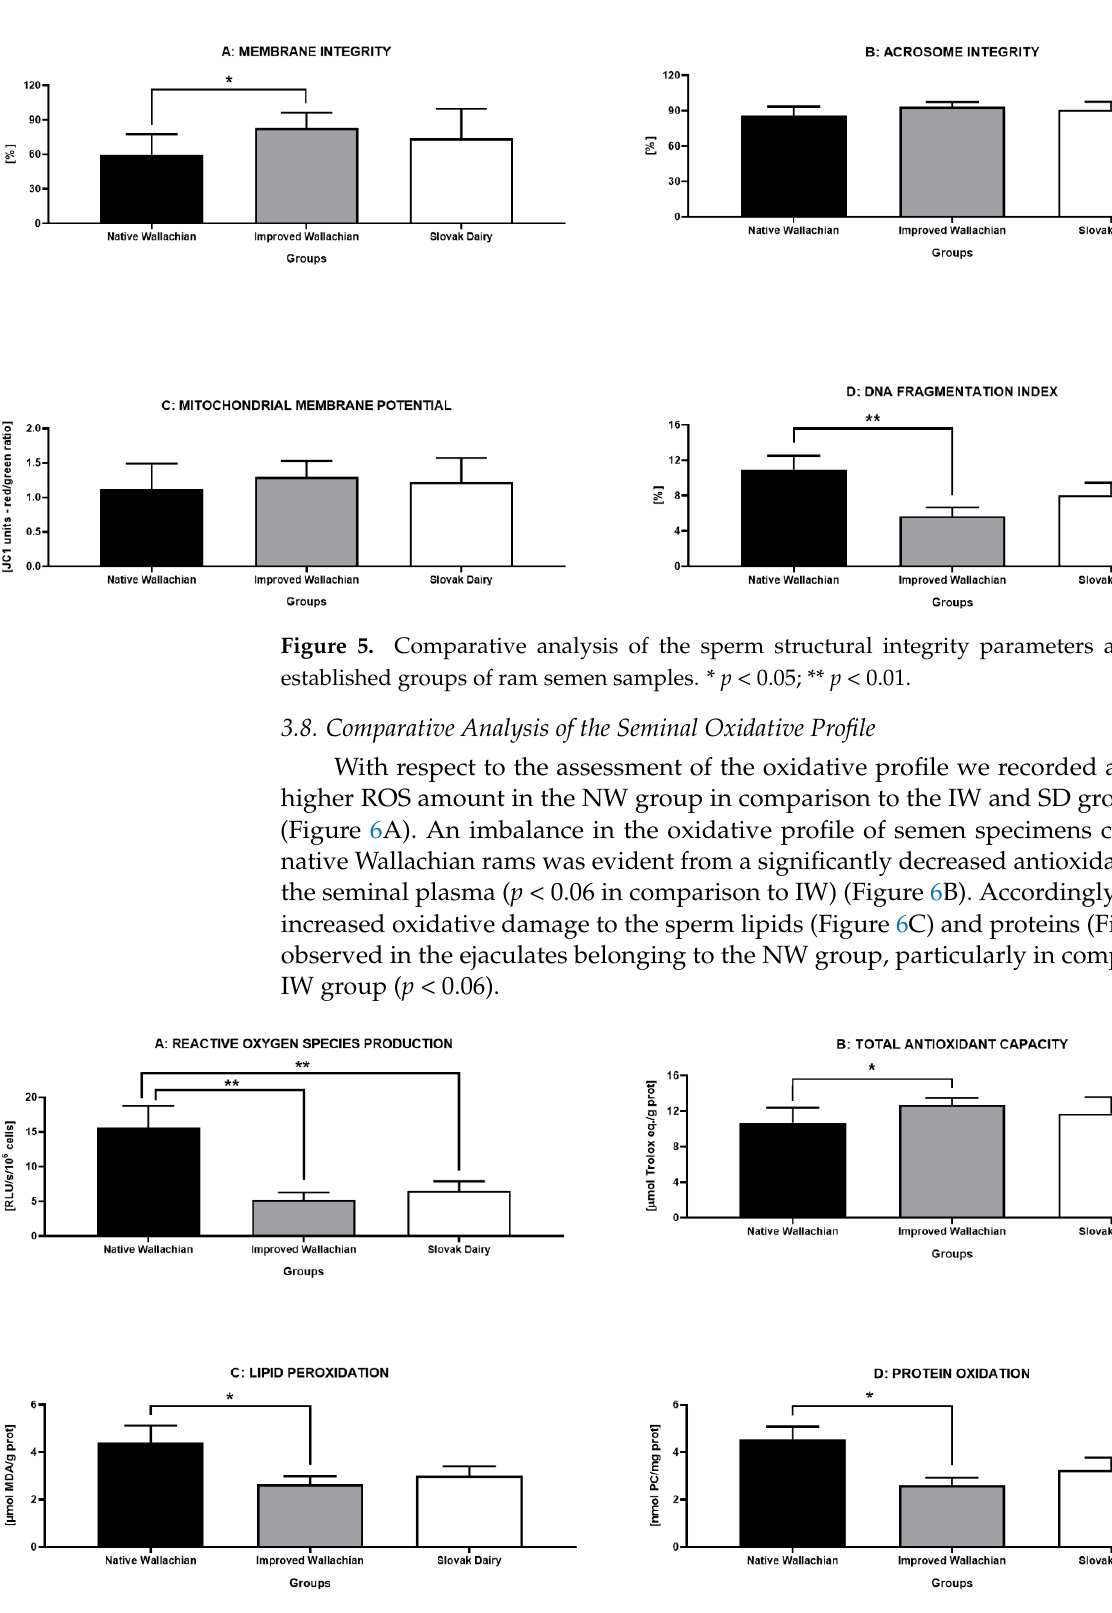
Figure 6. Comparative analysis of the oxidative profile markers among the pre-established groups of ram semen samples. * p < 0.05; ** p <